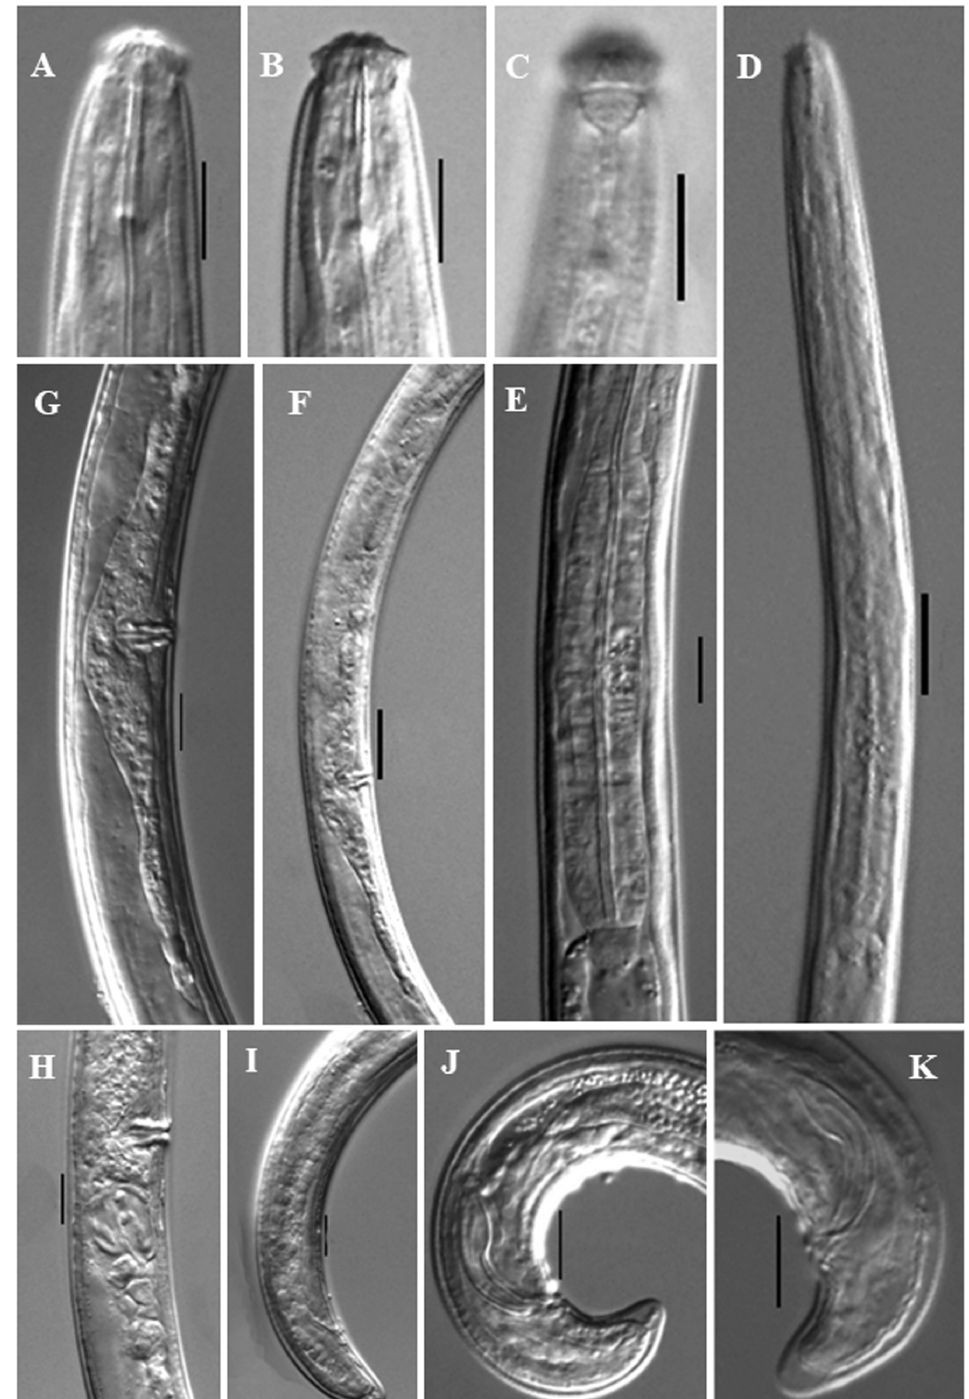
Fig. 8. Tylencholaimus macroamphidius sp. nov. (LM photographs). A–B, F, G, I . Holotype, ♀ (AMU/ ZD/NC/Tylencholaimus macroamphidius/1). C . Paratype 6, ♂ (slide 5). D–E . Paratype 2, ♀ (slide 3). H . Paratype 1, ♀ (slide 2). J . Paratype 7, ♂ (slide 6). K . Paratype 9, ♂ (slide 8). A–B . Female anterior region. C . Male anterior region showing amphid. D . Female pharyngeal region. E . Female expanded part of pharynx. F–H . Female genital system. I . Female posterior region. J . Male posterior region. K . Male posterior end showing spicules. Scale bars: A–C, E, G–K = 10 μm; D, F = 20